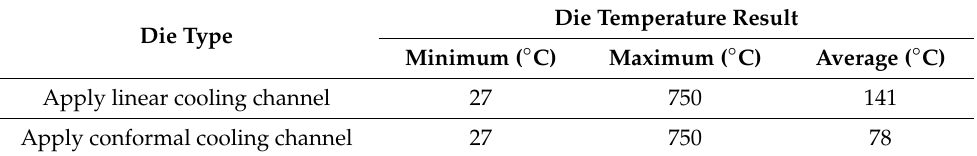
Figure 12. Comparison of the average temperature of each die in the continuous process heat flow ( a ) die applied to conformal cooling channel of this study ( b ) die applied with conventional linear cooling channel. Table 9. Temperature comparison of each die as a result of the continuous process heat